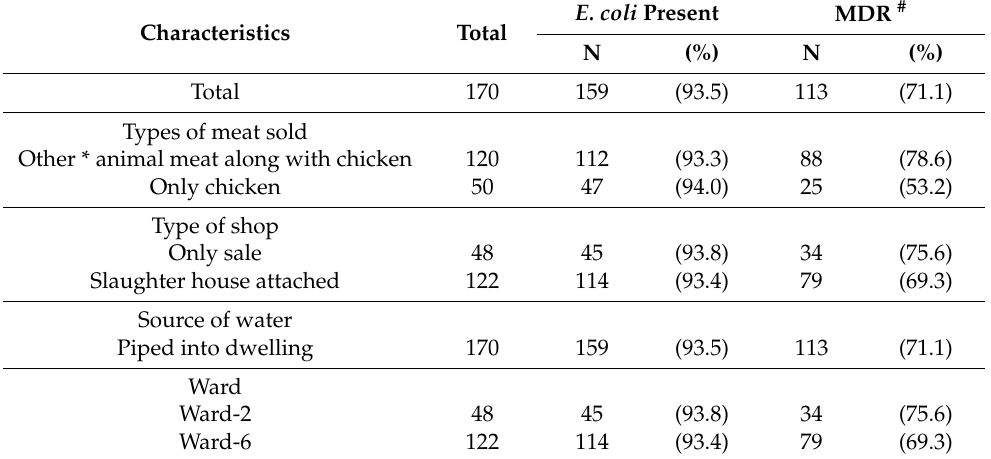
Table 1. Characteristics of the distribution of the prevalence of E. coli and MDR in the E. coli isolated from chicken cecal samples from retail shops in two selected wards of the Dhulikhel municipality of Nepal, from September to December 2021.